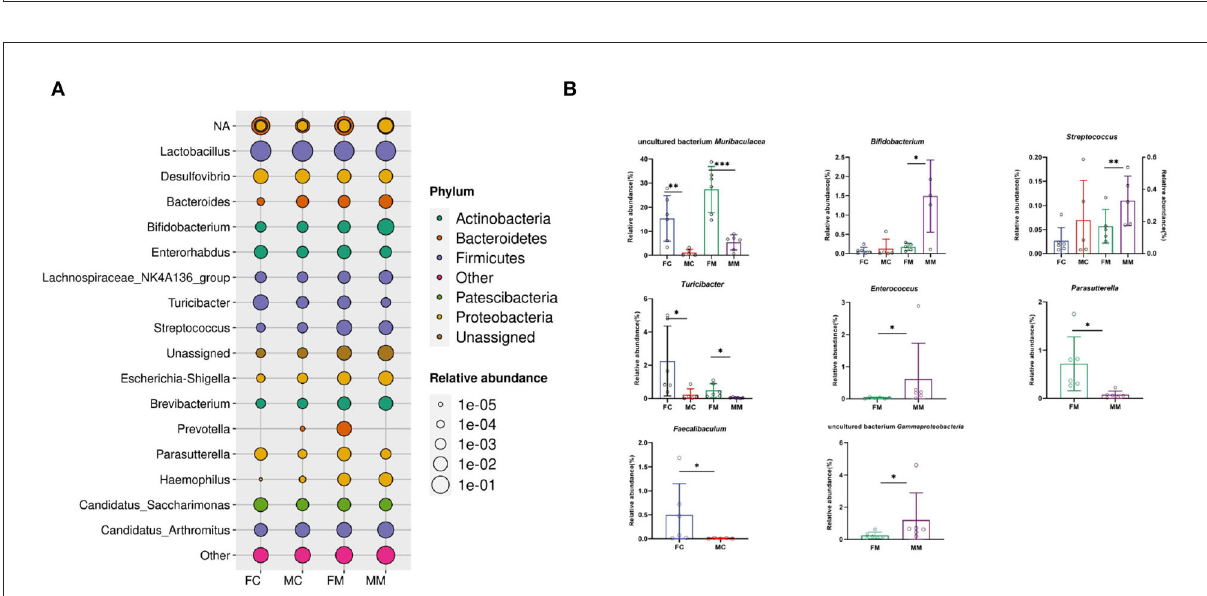
bacterial genera were associated with E2 secretion and nine with T secretion in MAM. In both physiology and pathology, MAM seems to be more susceptible to the host than to LM, which is